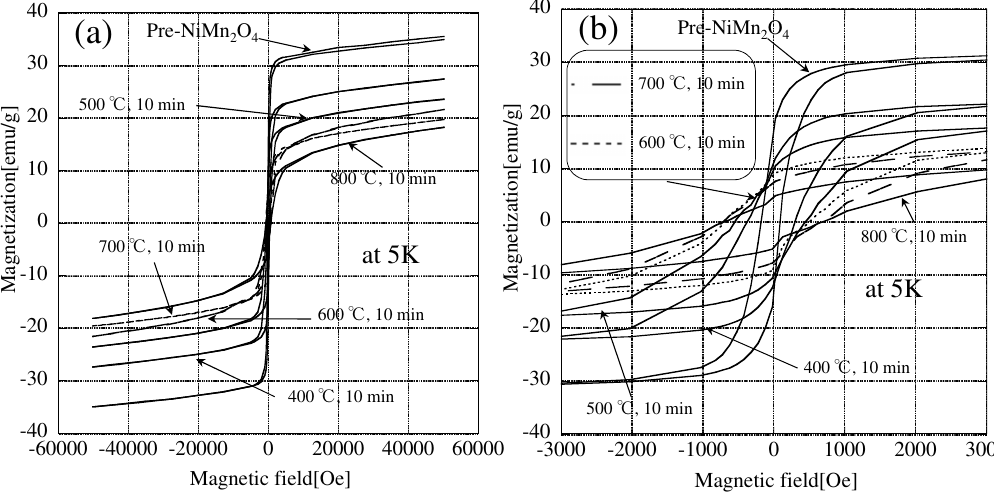
Figure 7. M-H loops of NiMn 2 O 4 irradiated with a microwave H-field at different temperatures. ( a ) Full loops and ( b ) magnification ( − 3000–3000 Oe).